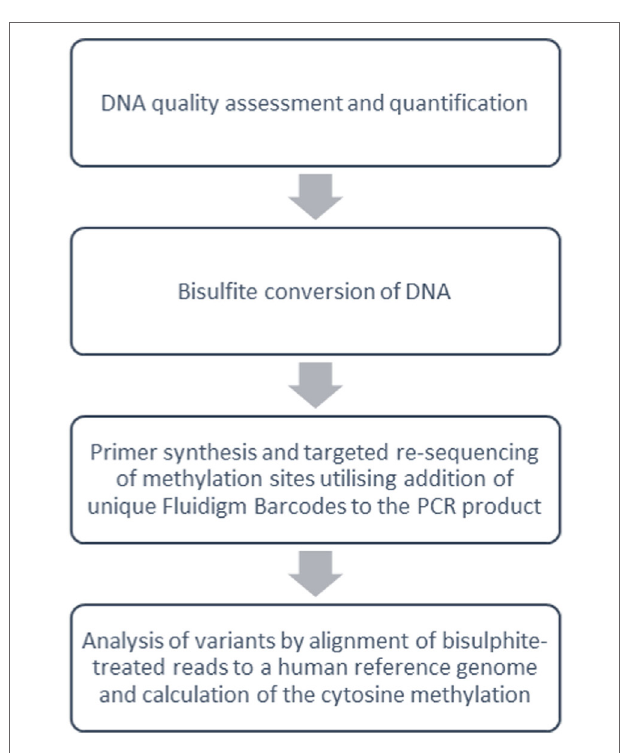
FigUre 3 | Overview of targeted DNA methylation analysis methods. Summary work-flow of bisulfite Amplicon Sequencing using a next- generation sequencing approach with the Illumina sequencing platform (Fluidigm, CA, USA).